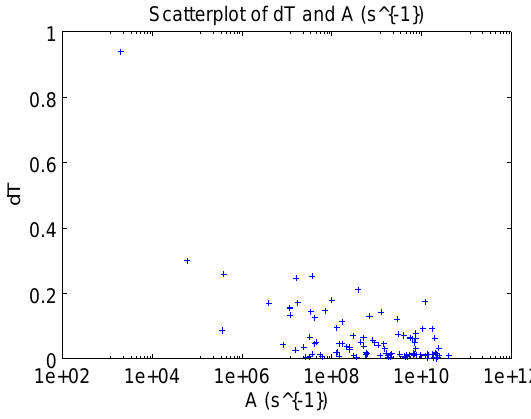
Figure 6. Scatterplot of dT and A ( s − 1